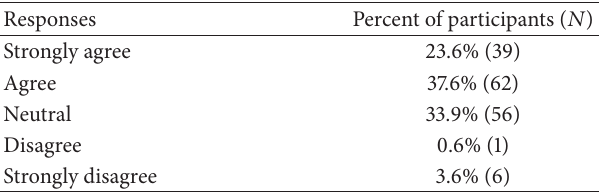
Table 5: Patient responses to the following question: “Are you at increased risk of having skin cancer because of your IBD and the medications that you take for the treatment of